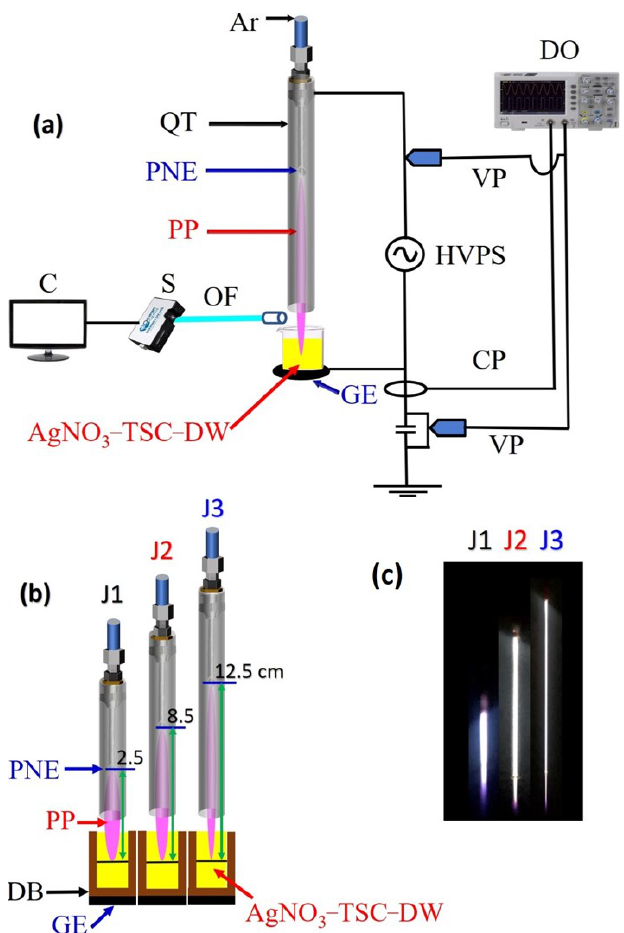
Figure 1. ( a ) Experimental layout of a plasma jet device for synthesis of silver nanoparticles; ( b ) schematic diagram; ( c ) photos of the J1, J2, and J3 jets. In ( a , b ), Ar , argon gas; QT , quartz tube; PNE , powered needle electrode; PP , plasma plume; OF optical fiber; S , spectrometer; C , com- puter; DB , dielectric barrier; GE , grounded electrode; AgNO 3 -TSC-DW , AgNO 3 -TSC-DW solution for synthesis of silver nanoparticles; HVPS , high voltage power supply; VP , voltage probe; CP , Current probe; DO , digital